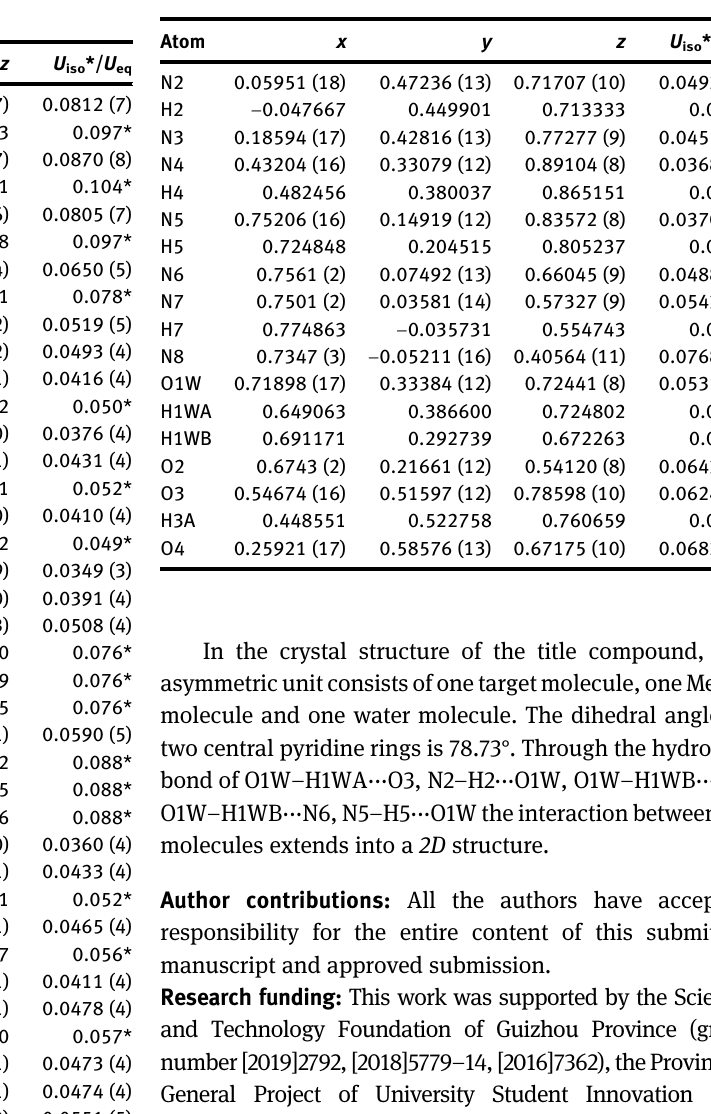
Table  : Fractional atomic coordinates and isotropic or equivalent isotropic displacement parameters (Å 